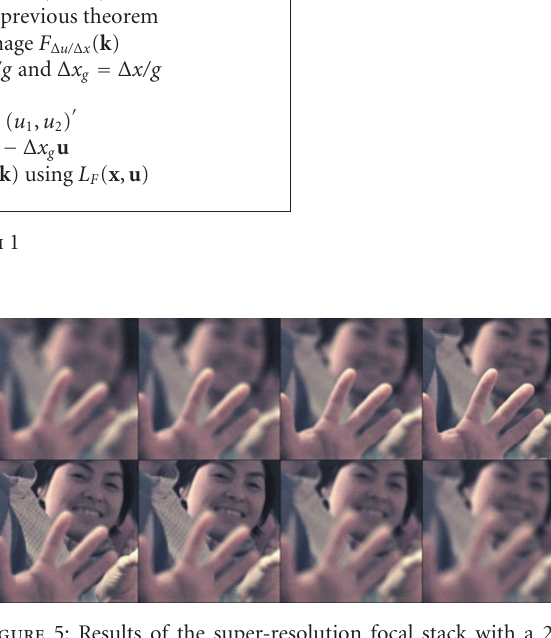
Figure 5: Results of the super-resolution focal stack with a 25 × resolution